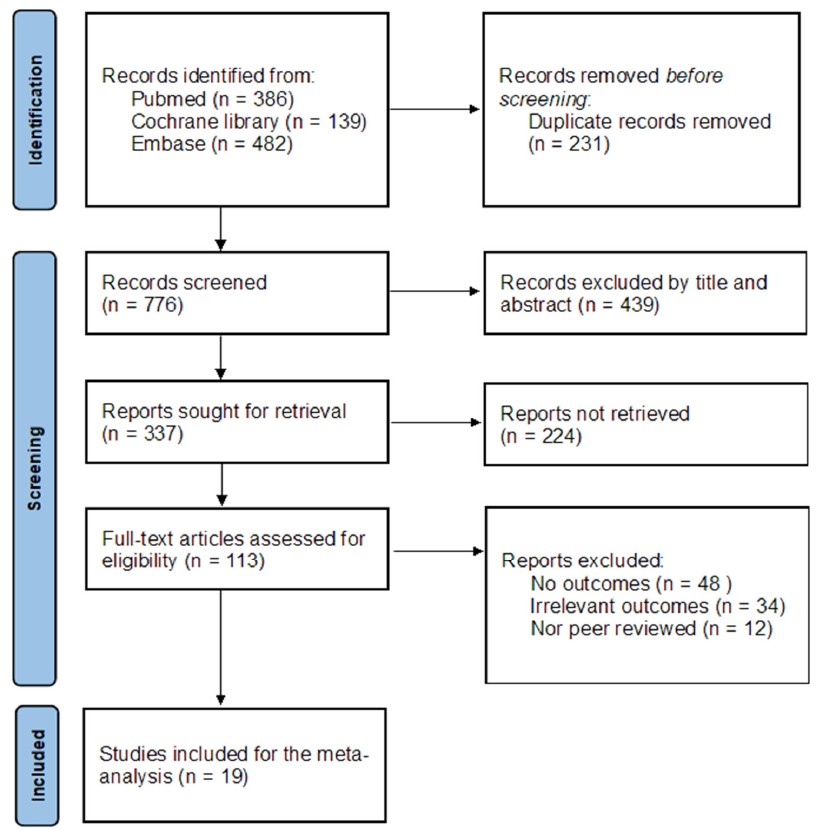
Figure 1. The PRISMA 2020 flow diagram for the meta-analysis.